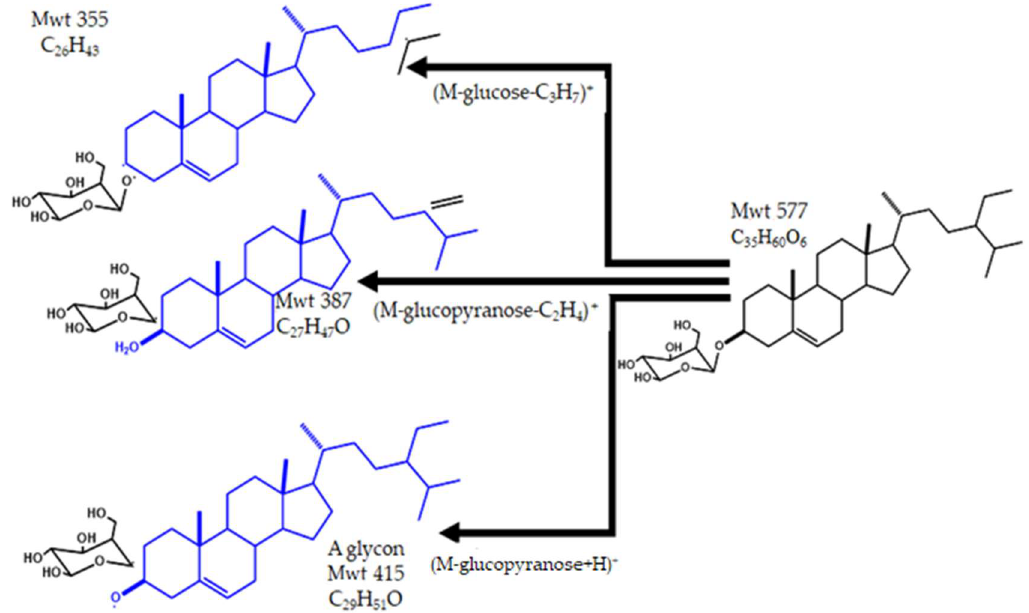
Figure 11. The structure and fragmentation of β –sitosterol– β – D